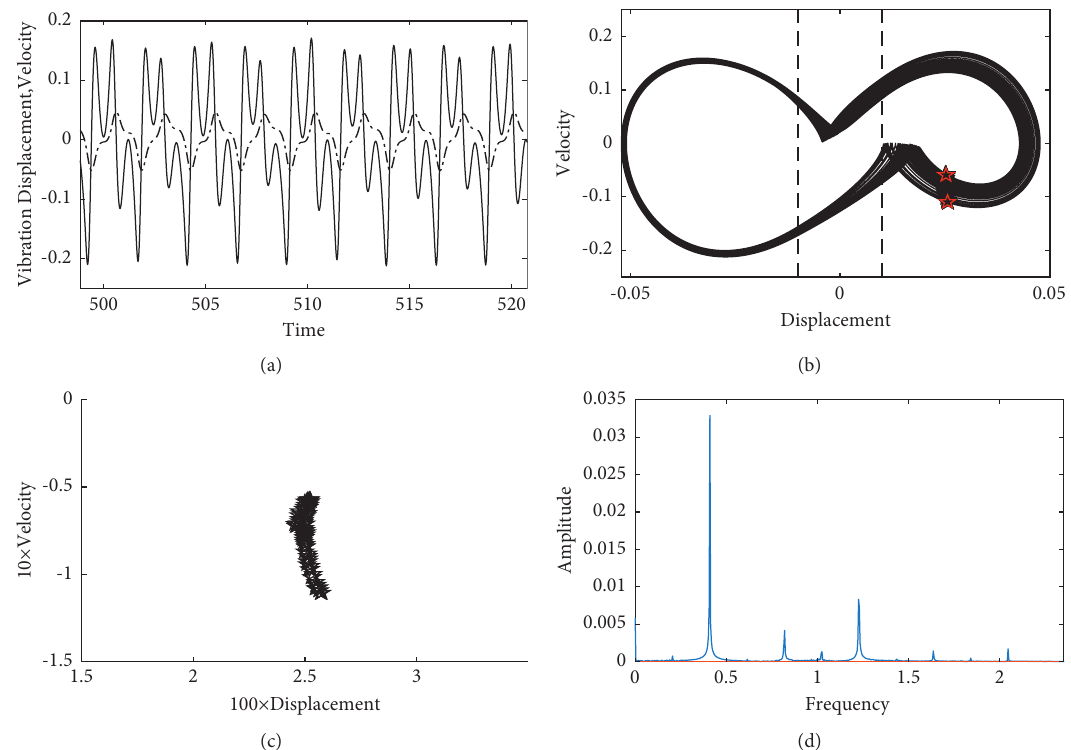
Figure 8: : f � 0 . 410 Hz ， quasiperiodic motion. (a) Time history graph. (b) Phase diagram. (c) Poincar´e section. (d) Power spectral density